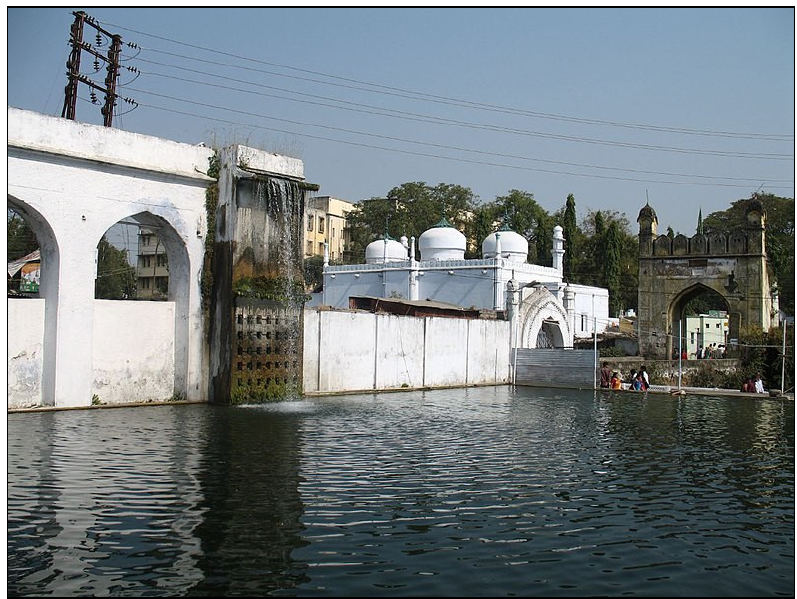
Figure 16. Panchakki , an example of an Indian water mill in Aurangabad, Maharashtra (adapted from [41]).